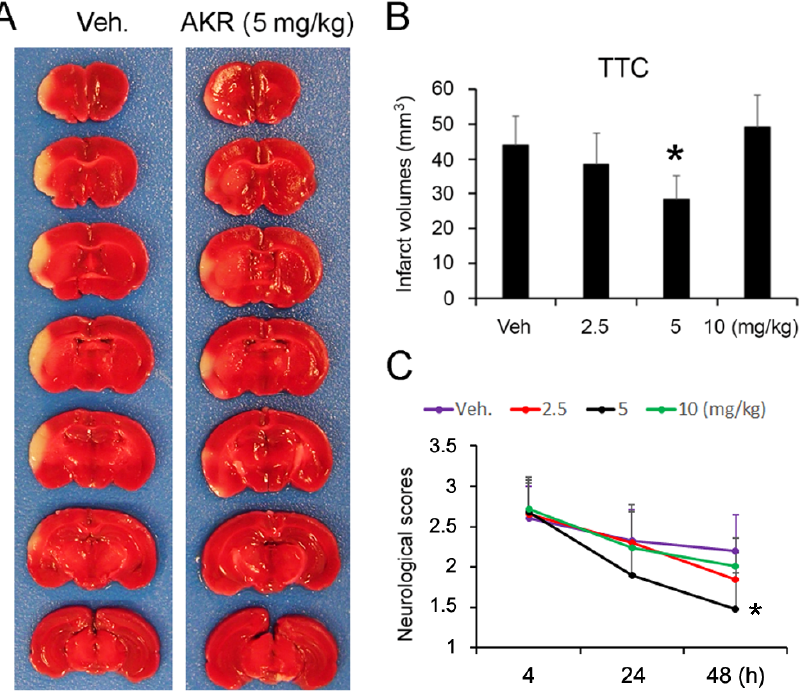
Figure 2. AKR1C15 reduced infarct volumes and neurological deficits after MCAO. TAT-AKR1C15 or vehicle (Veh.) was i.p. injected at indicated doses right after MCAO. ( A ) Representative photographs of TTC-stained brain sections and ( B ) calculated infarct volumes at 48 h after MCAO. Data are mean ± SD; n = 7–9 animals per group. One-way ANOVA followed by post hoc Tukey’s multiple comparison. ( C ) Neurological scores at 48 h after MCAO. Two-way ANOVA followed by post hoc Tukey’s multiple comparison. Data are mean ± SD; n = 7–9 animals per group. * p < 0.05 vs. Veh.